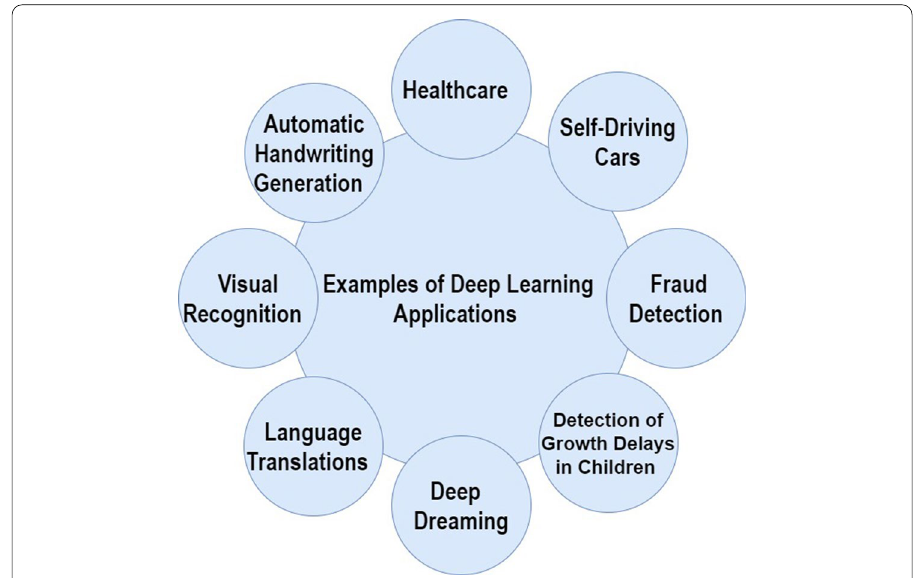
Fig. 29 Examples of DL applications